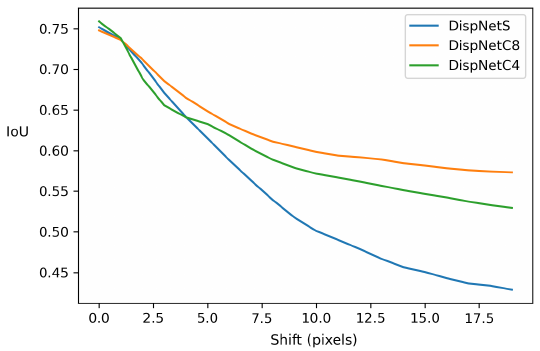
Figure 11. Effect of shift between left and right images upon inference